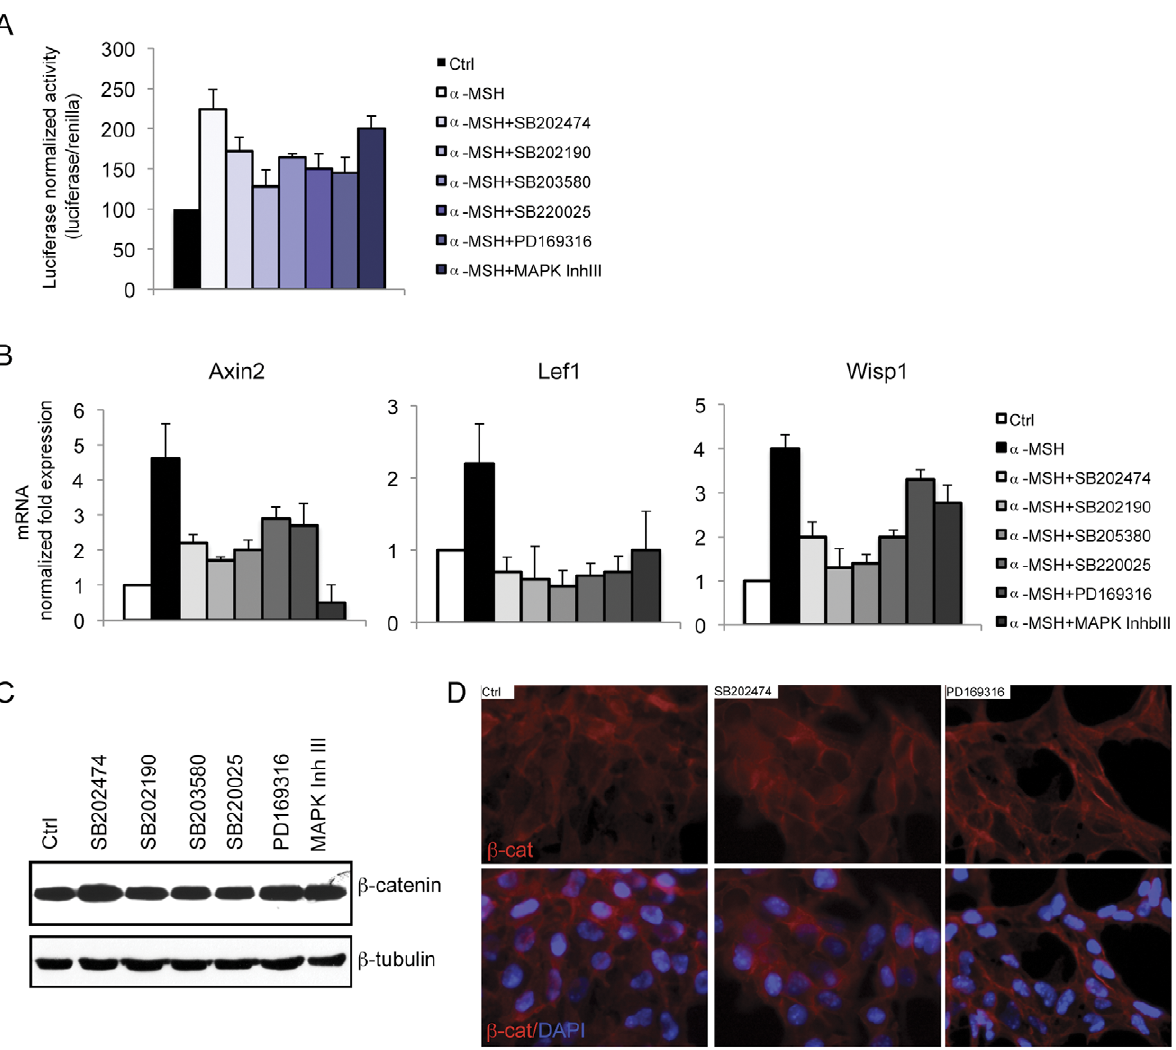
Figure 6. Regulation of Wnt/ b -catenin signaling by pyridinyl imidazoles. (A) Inhibition of the b -catenin/Tcf/Lef1-responsive luciferase reporter gene by PI compounds. The pTK-Renilla was inserted as an internal control. Twenty-four hours after transfection, cells were treated with PI compounds (SB202474, SB202190, SB203580, SB220025, PD169316 20 m M: MAPK Inh III 10 m M) for 6 h. Firefly luciferase activity, normalized to the corresponding renilla luciferase activity was expressed as fold decrease compared with control cells. Values represent mean 6 SD of